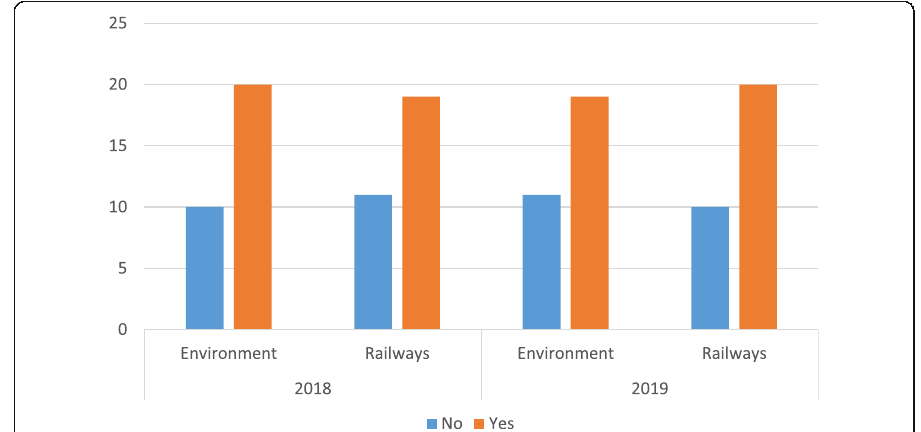
Fig. 5 Environmental sustainability or railways mentioned in sea port webpages of analyzed